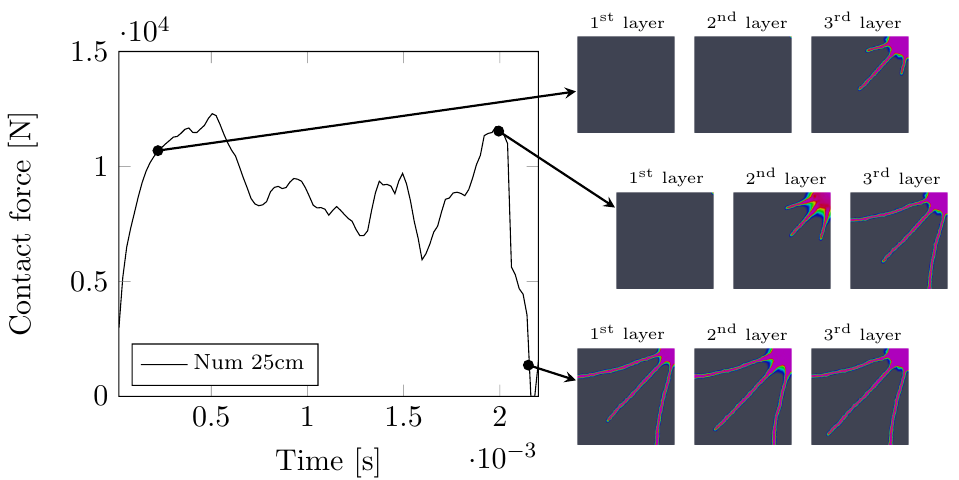
Figure 17. Evolution of cracks in 5LG laminate due to impact height h imp = 25 cm; the 1st layer is the impacted one.